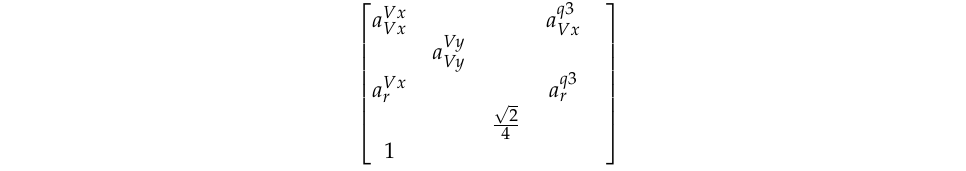
Table 5. Stability matrix for longitudinal motion in horizontal evolution A .